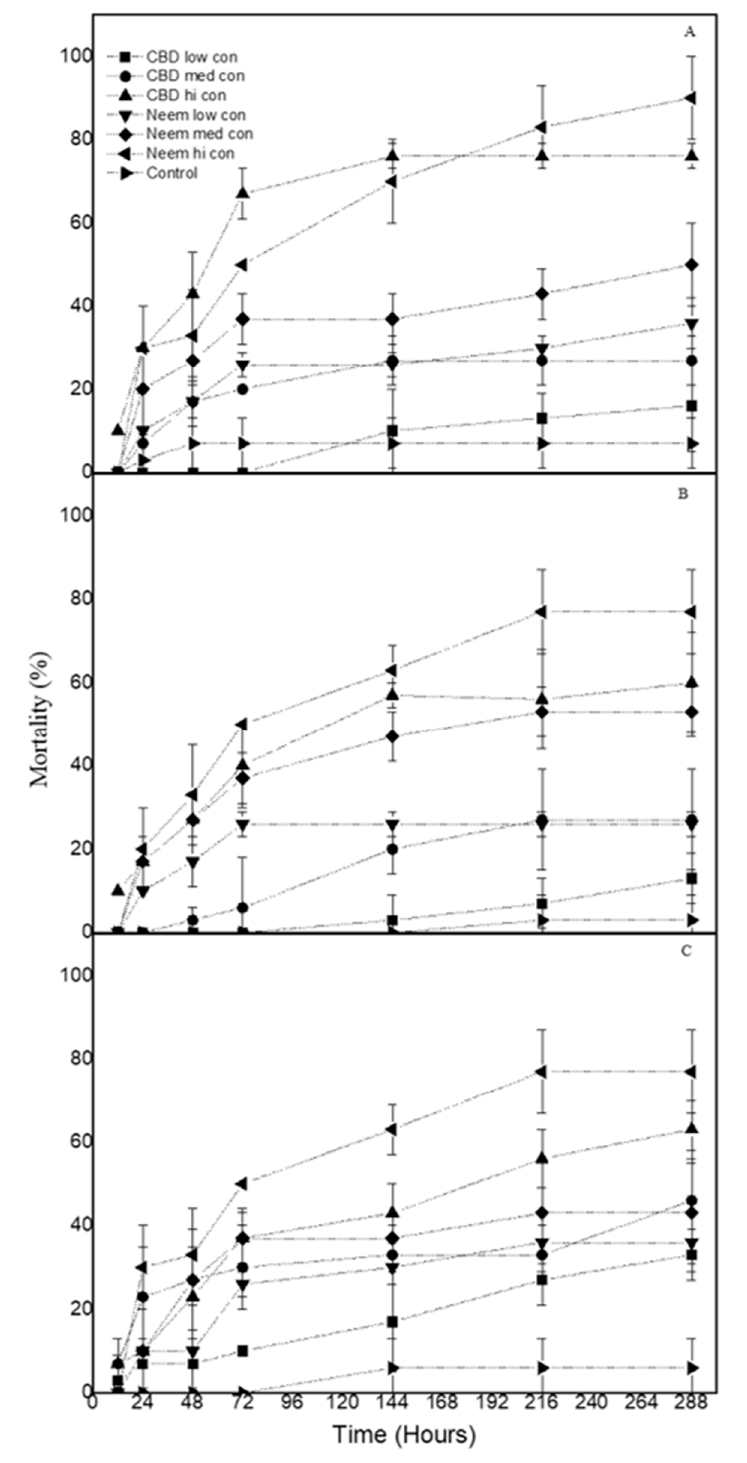
Figure 3. Mortality (% ± sd) of P. interpunctella larvae treated with CBD oil and neem oil at three concentrations on ( A ) wheat ( B ) corn and ( C ) rice. (low con: 15 mg/mL, med con: 45 mg/mL, hi con: 90 mg/mL).